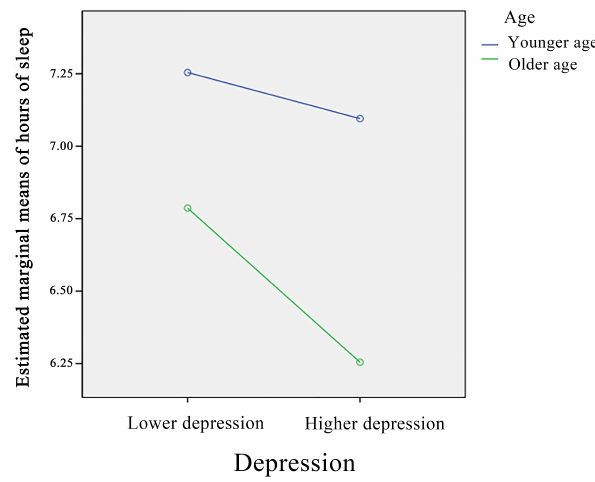
Fig. 2. Depression and age on hours of sleep across young adult